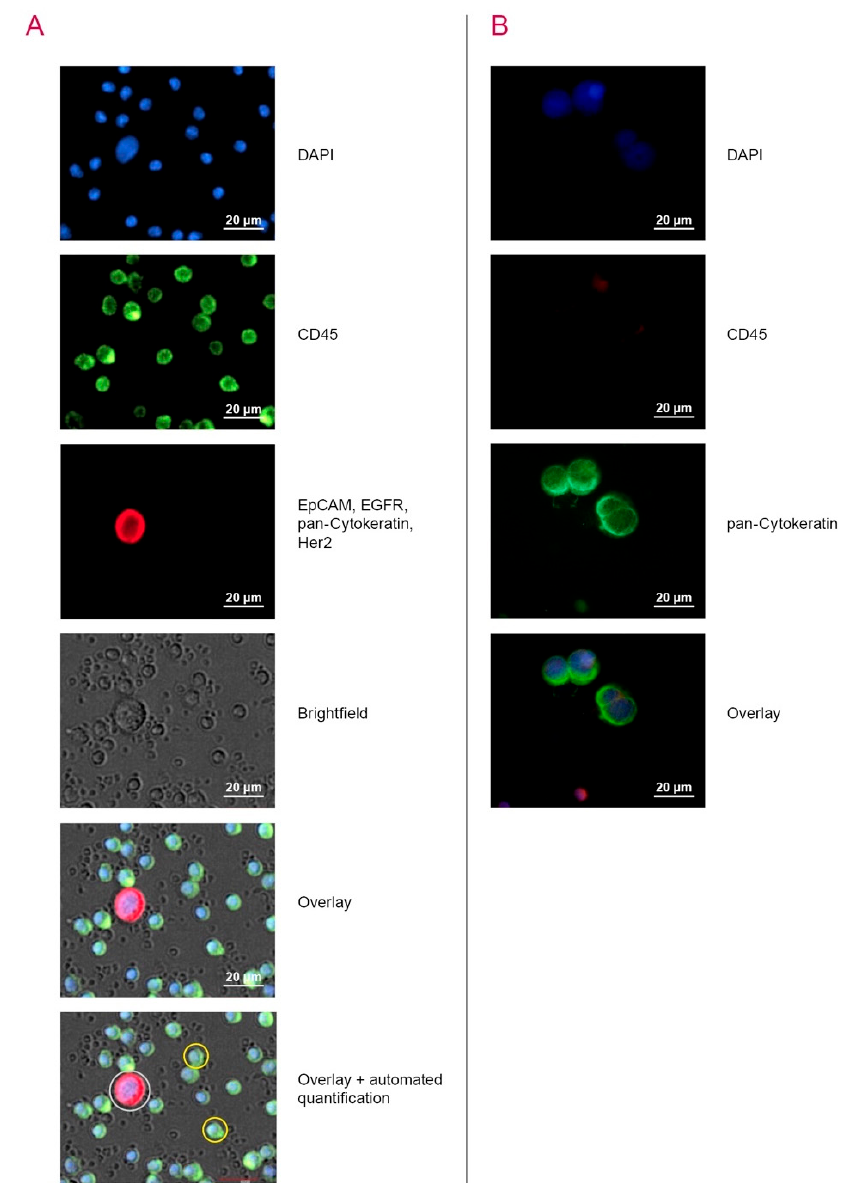
Figure 1. Validation of circulating tumour cells (CTC) detection by spiking experiments with HT29 colon cancer cells. HT29 cells were spiked into healthy donors´ blood samples. ( A ) NYONE ® —After sample preparation, HT29 cells (red) were stained and identified with the NYONE ® cell imager and marked for automated quantification. Leukocytes were stained in green (yellow encirclement) and not considered for quantification. ( B ) ScreenCell ® —HT-29 cells were immunofluorescence (IF) stained with anti-pan-CK antibodies (green) and leukocytes were IF stained with anti-CD45 antibodies (red). Detected HT29 cells were significantly larger compared to leucocytes.